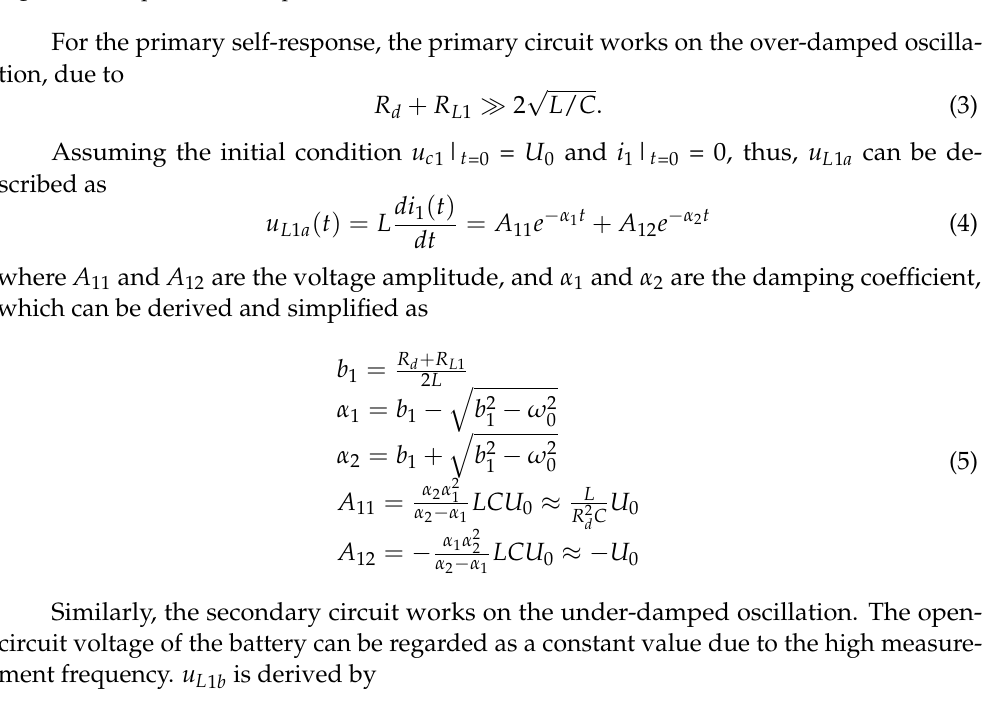
Figure 4. Composition of response u L 1 .